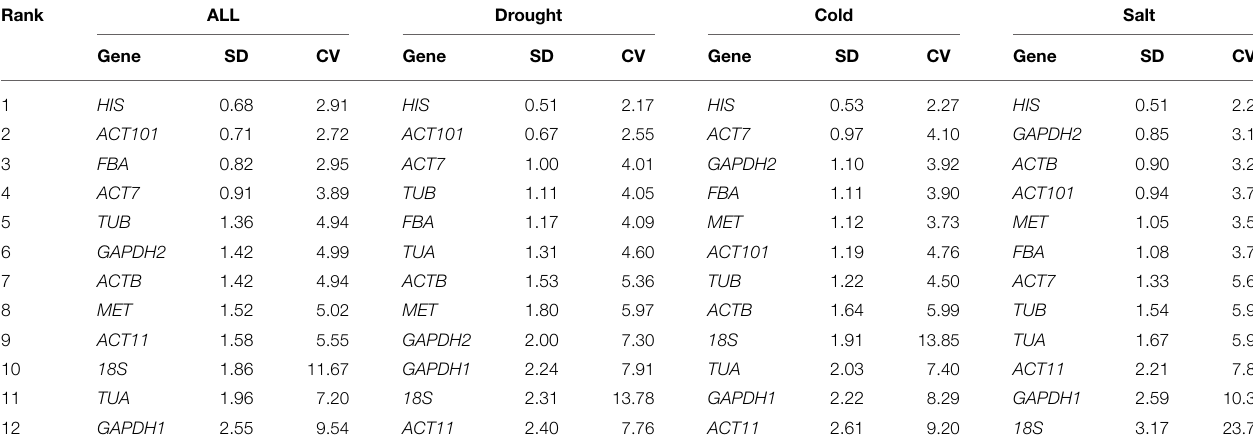
TABLE 4 | Expression stability of 12 candidate reference genes calculated by BestKeeper. Rank